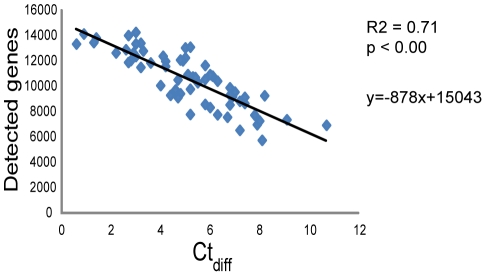
Linear regression analysis.Regression model describing how much of the variation in number of detected genes on the array can be explained by sample quality after extraction (Ctdiff).